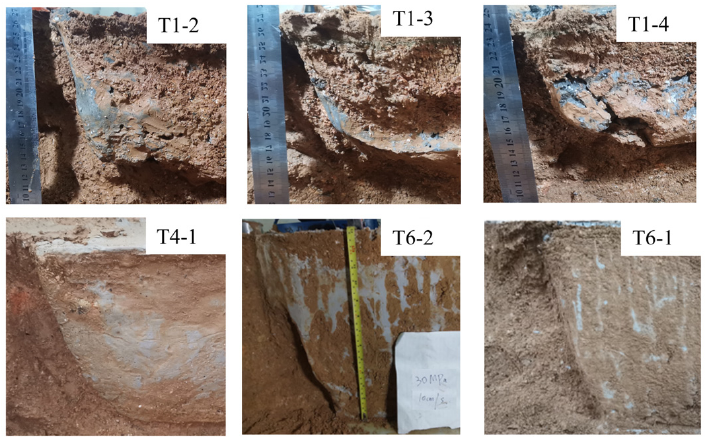
Figure 7. Photos of erosion groove shapes.